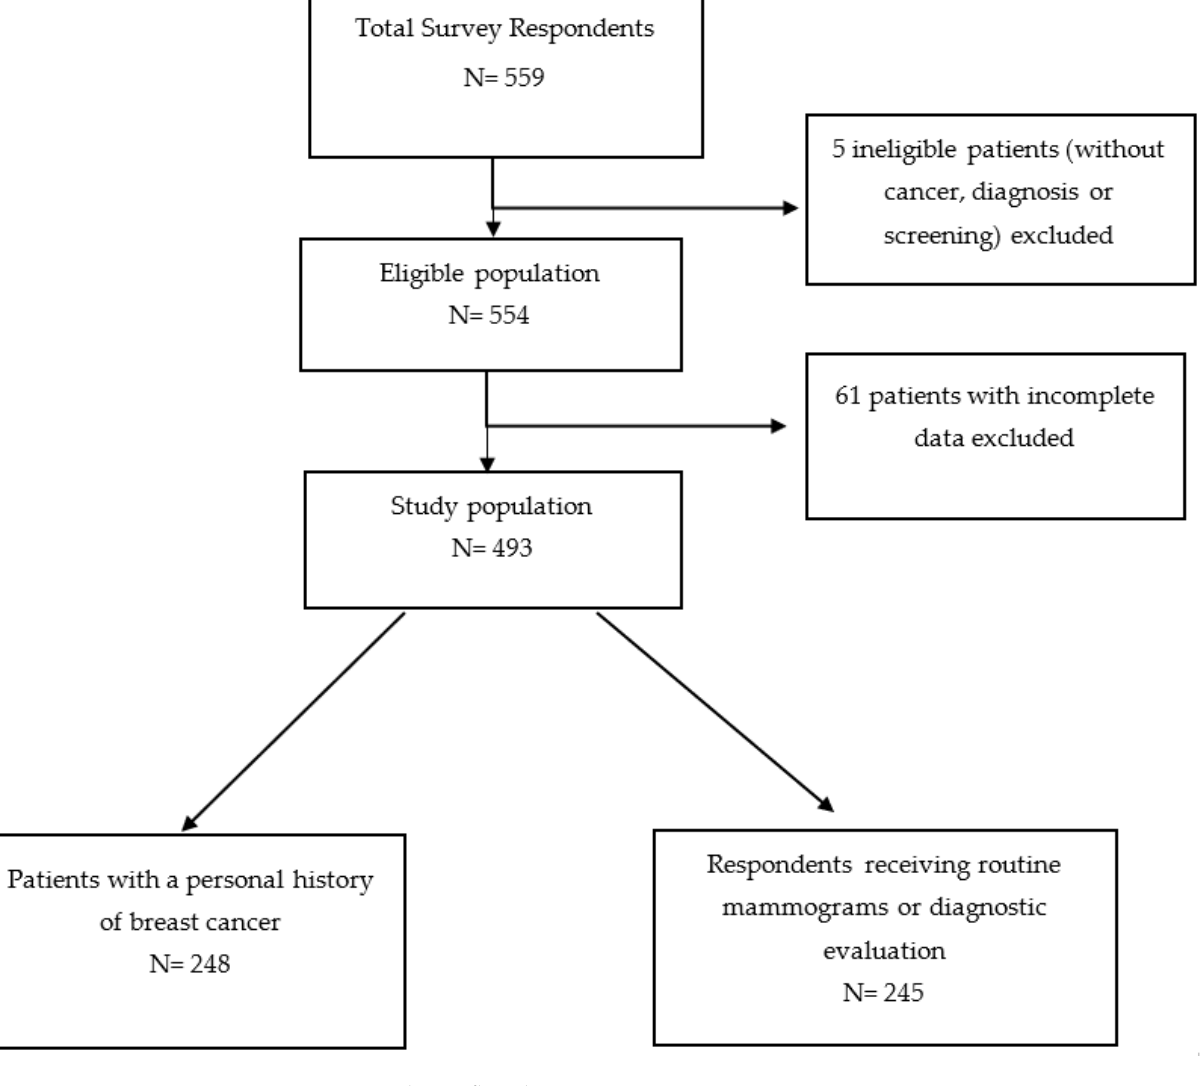
Figure 1. Population flowchart. Table 1. Survey participant characteristics according to personal history of cancer .